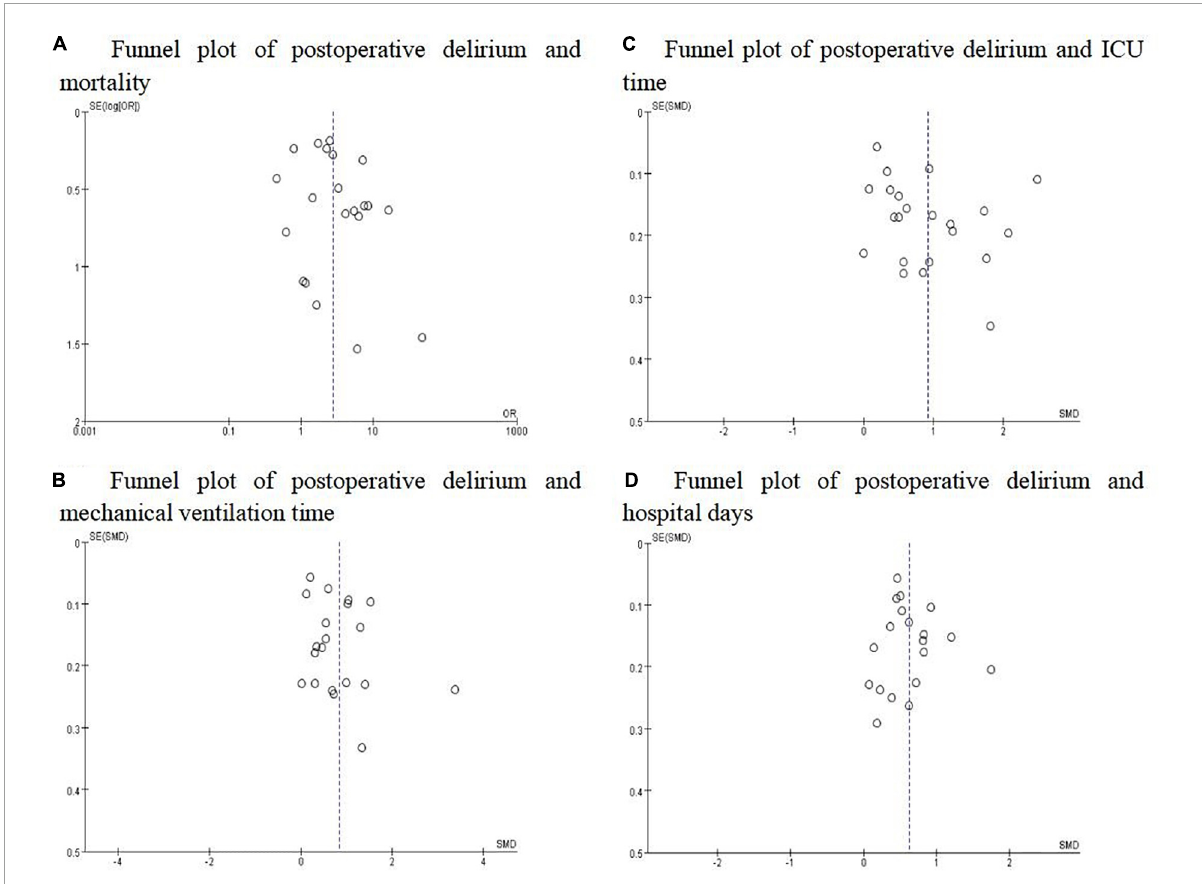
FIGURE3 Funnel plots for the studies involved in the meta-analysis. (A) Mortality; (B) Mechanical ventilation time; (C) ICU time; (D) Hospital days. The distribution was not completely symmetrical around the funnel plot, which suggested the possibility of publication bias.